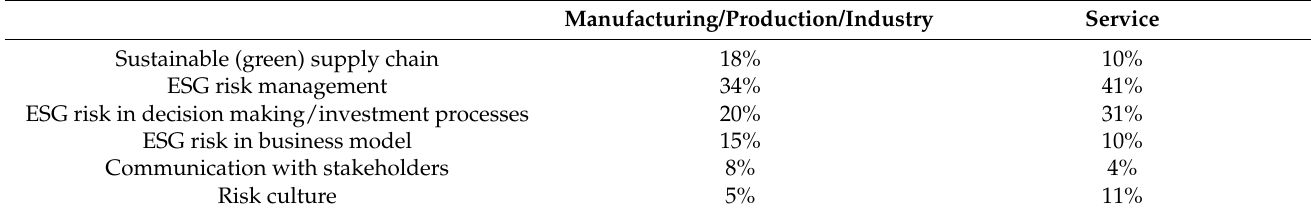
Table 6. ESG risk management practices and type of business activity.